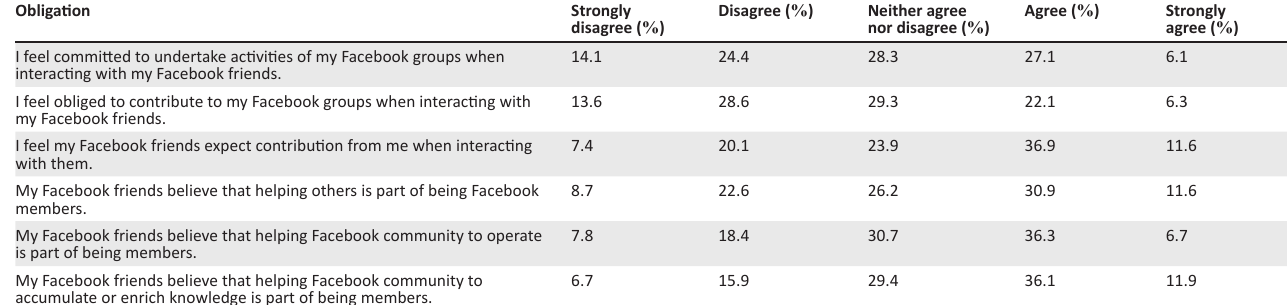
TABLE 4: Obligation frequencies ( n = 447).